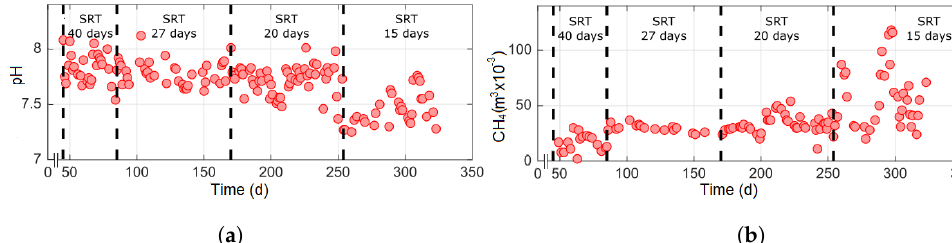
Figure 2. Time-course of. ( a ) pH in the effluent; ( b ) methane volume rate production (m 3 CH 4